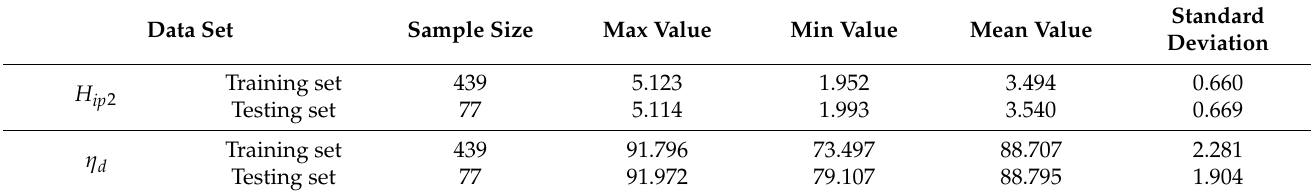
Table 3. Data set partitioning.